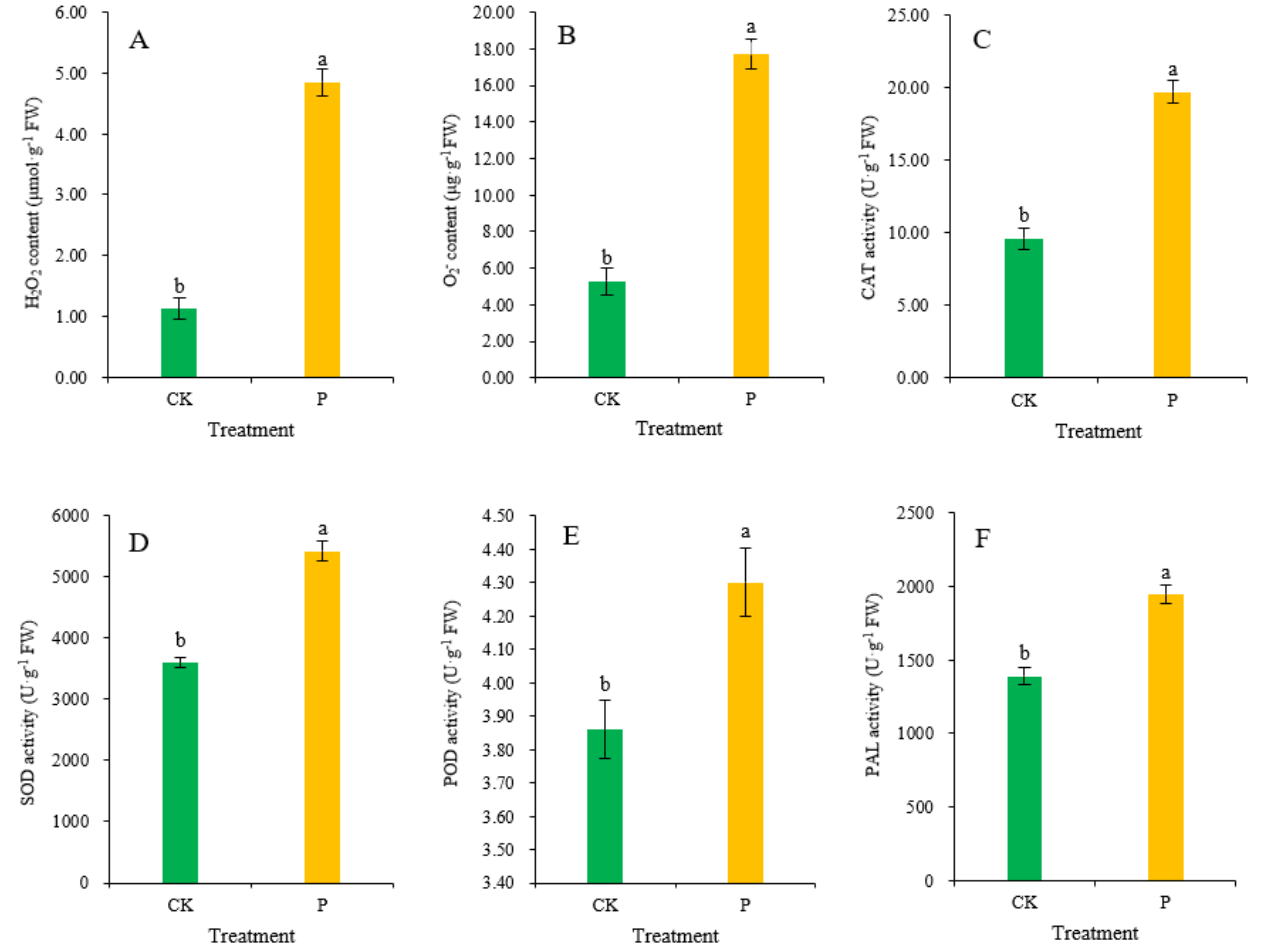
Figure 2. Effects of Pga inoculation on physiological changes of oat leaves. ( A ) H 2 O 2 content. ( B ) O 2 − content. ( C ) CAT activity. ( D ) SOD activity. ( E ) POD activity. ( F ) PAL activity. Data are expressed as mean ± SE ( n = 3). Data are means ± SD of three biological replicates ( n = 3) and different letters indicate significant difference at p ≤ 0.05 by the one-way ANOVA test. CK, no Pga inoculation; P, Pga inoculation.